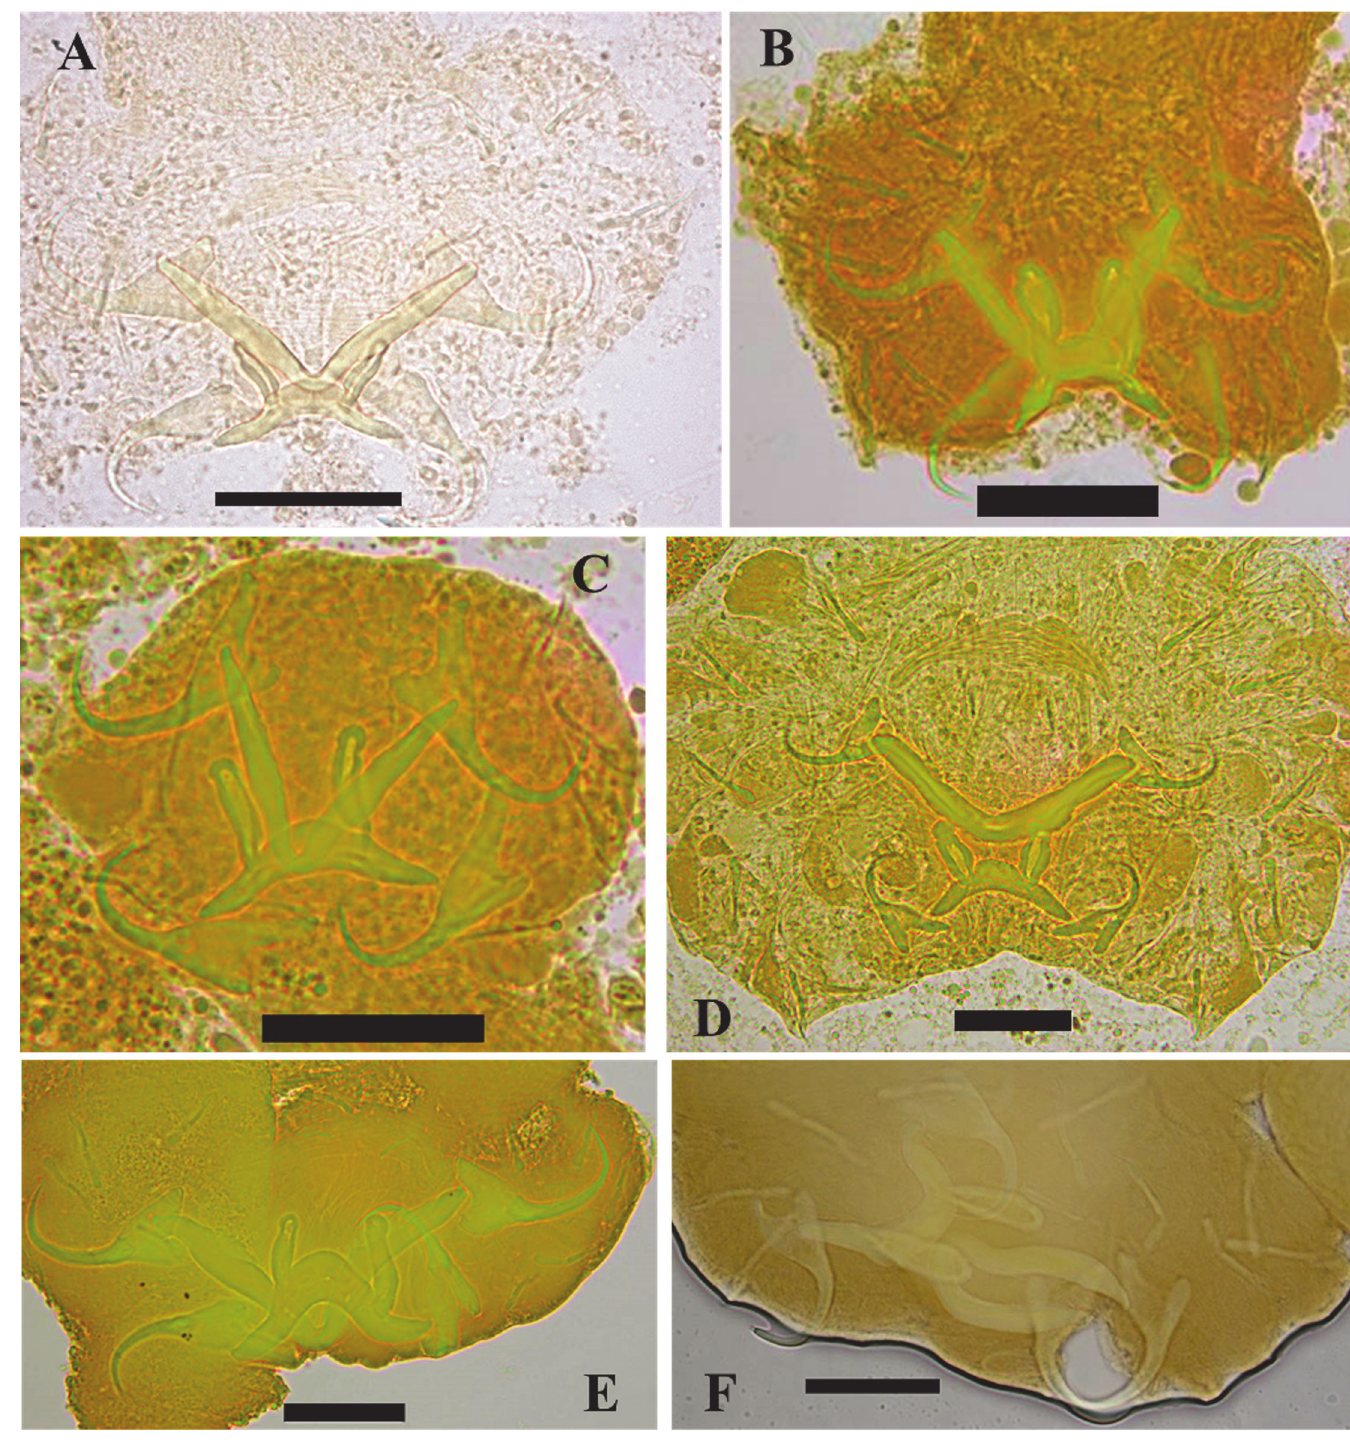
Fig 7. Haptoral morphology of the newly described Cichlidogyrus species infecting Simochromis and Pseudosimochromis cichlids. Micrographs depict the attachment organ of A. C . raeymaekersi sp. nov. B. C . muterezii sp. nov. C. C . banyankimbonai sp. nov. D. C . georgesmertensi sp. nov. E. C